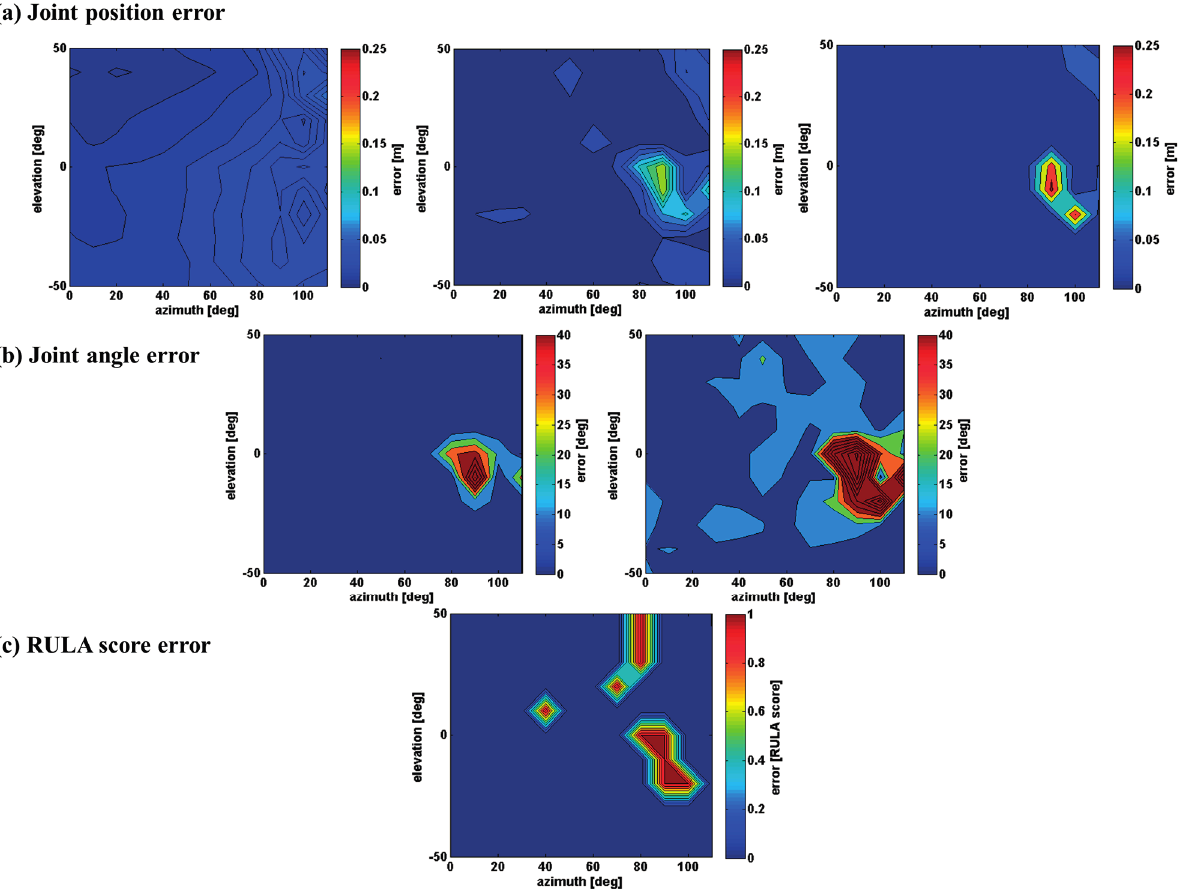
Figure 5. Accuracy of the Kinect measurement of the 135° swivel angle poses relative to azimuth and elevation pose parameters and with a zero elbow flexion ( a ) Error distribution of the shoulder (left), elbow (center) and wrist (right) joint positions estimated; ( b ) Error distribution of the shoulder (left) and elbow (right) joint angles calculated; ( c ) Error distribution of the resulting upper-body RULA